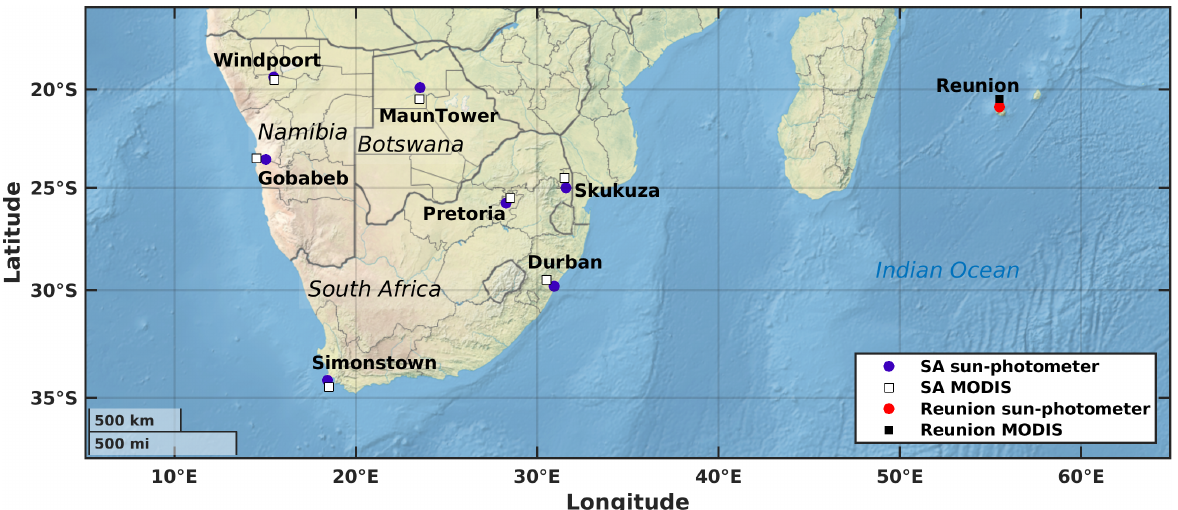
Figure 1. Geographical location of the eight sun photometer sites and of MODIS observations. The sites in South Africa (Pretoria, Skukuza, Simonstown, and Durban), Namibia (Gobabeb and Windpoort), and Botswana (Maun Tower) are identified by blue dots and white squares, and the Reunion site is shown with a red dot and a black square. Dots are for sun photometer and squares for MODIS observations. Table 1. Geographical information of the eight sun photometer sites. Note that the site’s name is shortened for readability: Reunion is known as “REUNION_ST_DENIS”, Pretoria is